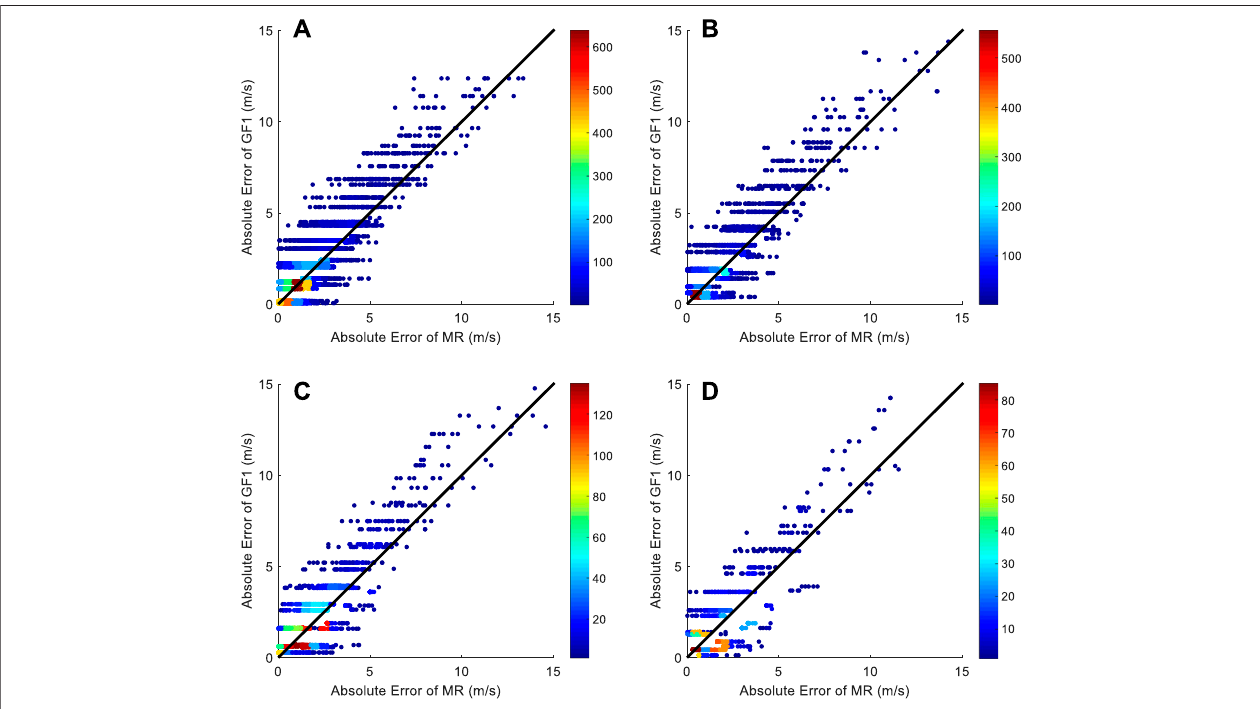
FIGURE 6 | The scatter diagrams of absolute errors ofthe multiple regression method (MR) and the wind gust factor method (GF1) for four different observed gust magnitudes: (A) 14 – 16 m/s, (B) 16 – 18 m/s, (C) 18 – 20 m/s, (D) 20 – 22 m/s. The color in the scatter in the fi gure indicates the number of repeated scatter points.